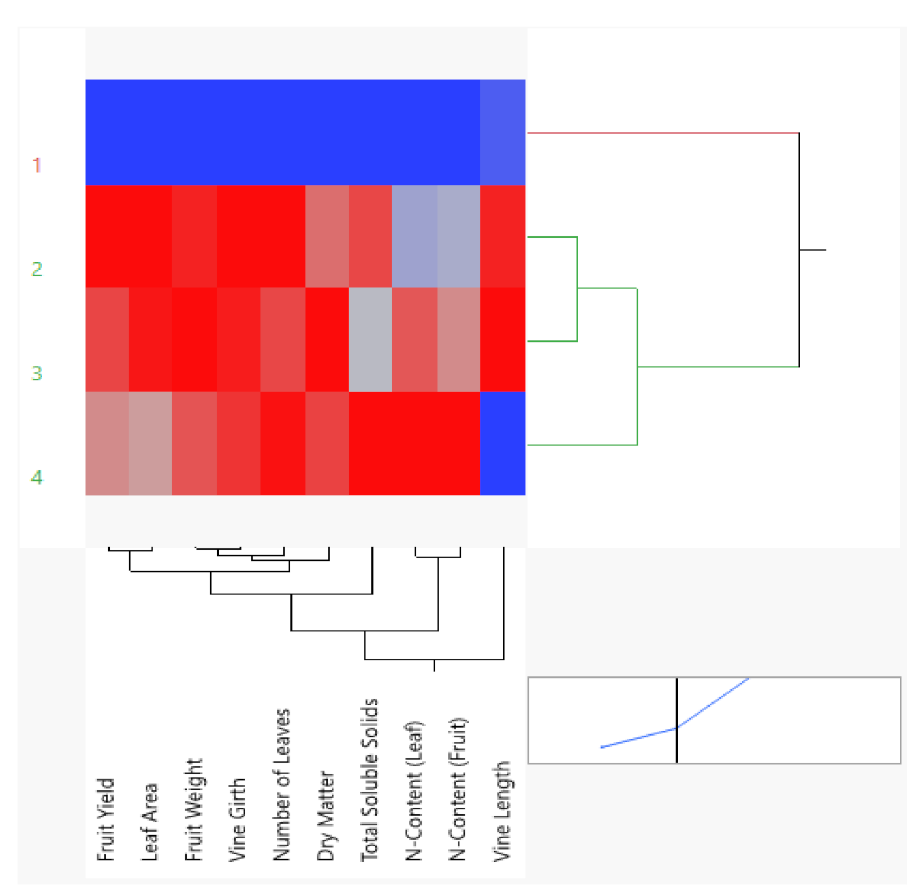
Figure 4. Two-way hierarchical clustering using Agglomerative Hierarchical Clustering (AHC) approach to figure out the Euclidean distance matrix for productivity-enhancing traits of cucumber under 4 treatments. The heat plot was assembled in JMP pro. Based on Ward’s minimum variance method, V. 16 (SAS Institute Inc., Cary, NC, USA). Both the vertical and horizontal axes represent clades formation based on division related to traits under different